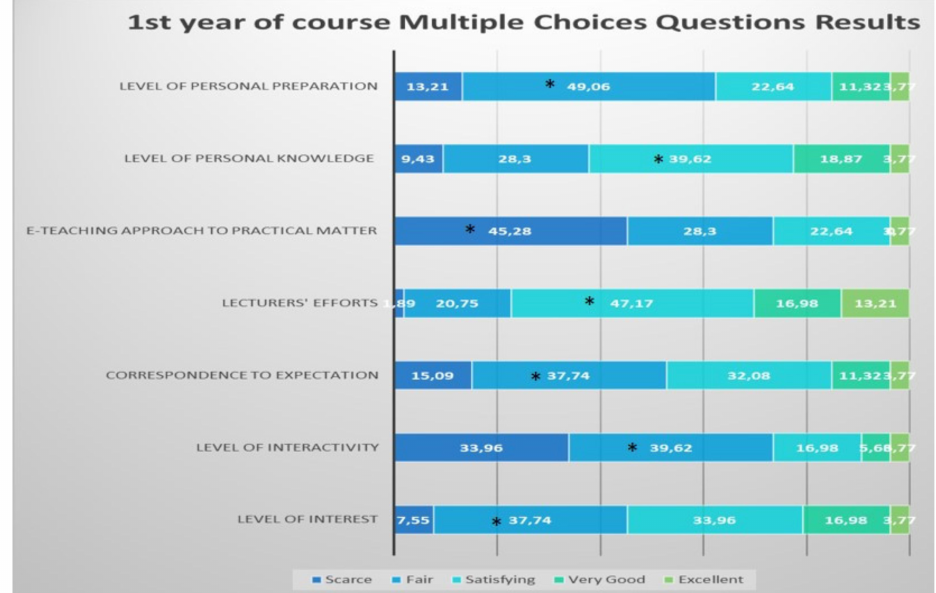
Figure 2. Questionnaire results for the first year student feedback to the e-learning and e-teaching approach. The numbers in the bars indicate the percentages of the answers received ( n = 301). * p < 0.05 (Pearson’s chi-squared